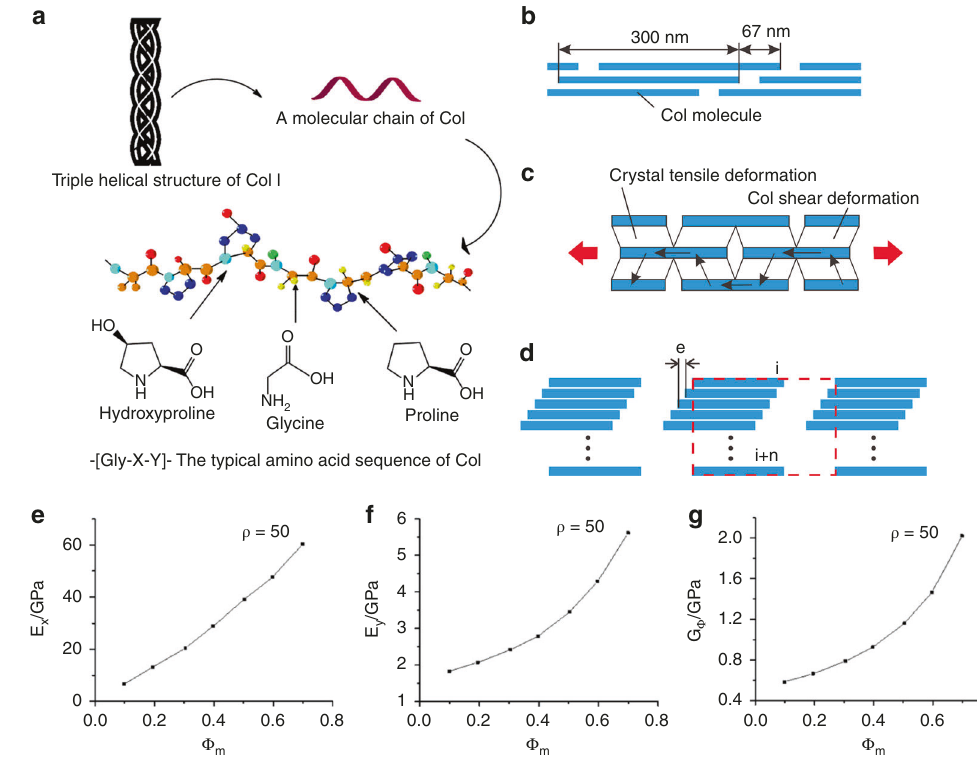
Fig. 4 Structure and mechanical properties of Col fi bers. a Special triple helix structure and amino acid sequence of type I Col 165 . b Mineralized Col fi ber structure model. c Mineralized Col fi ber stress transfer model. d Schematic of RVE that is indicated by the red dashed line. e Changes in longitudinal elastic modulus with degrees of mineralization changes. f Changes in lateral elastic modulus with degrees of mineralization changes. g Changes in shear elastic modulus with degrees of mineralization changes 166 . Figures adapted with permission from refs.